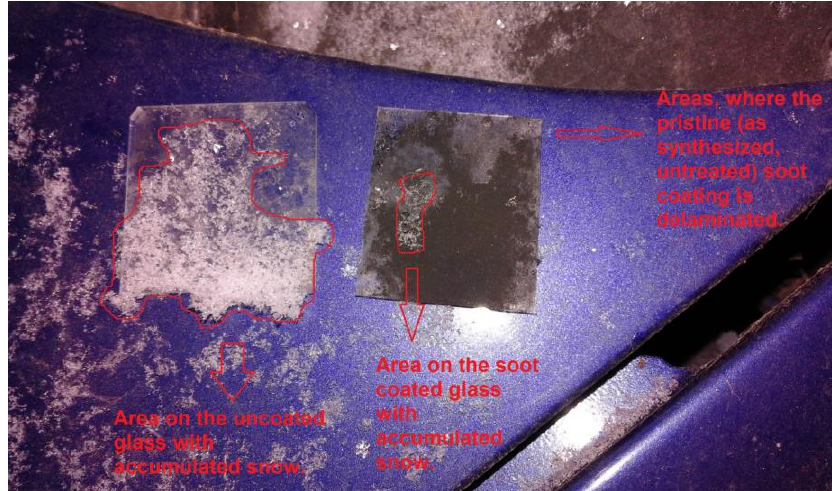
Figure 6. Snow and ice accumulation on an uncoated (left side) and soot coated (right side) glass slide upon prolonged 7 days exposure to real-life winter conditions ( T ~ − 2 ÷ − 5 °C; RH — 60% – 80%). The experiments are performed at Scientific Complex 2 of Bulgarian Academy of Sciences, Sofia, Bulgaria in January 2018. As seen, about 75% of the surface area of the uncoated glass is covered with snow/ice, whereas not more than 5% is the region with attached snow/ice on the soot coating.